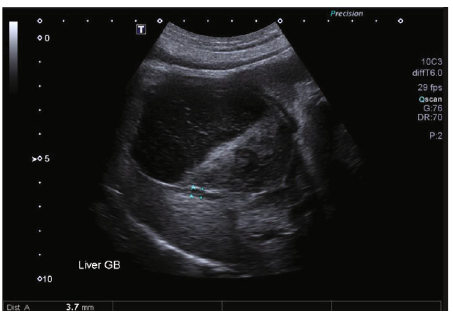
Figure Ultrasonographic image of the gallbladder, demonstrating a thickened and hypoechoic wall, consistent with edema. The surrounding fat is hyperechoic.